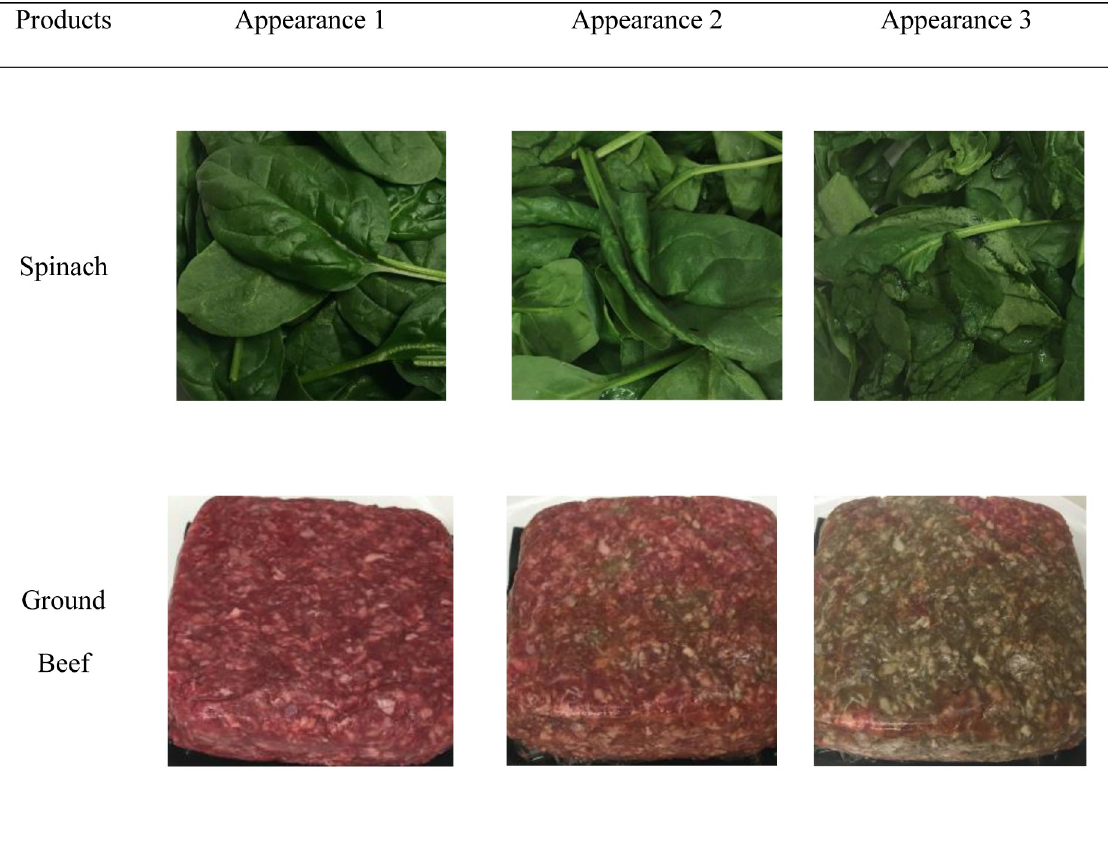
Fig 1. Cosmetic deterioration of spinach and ground